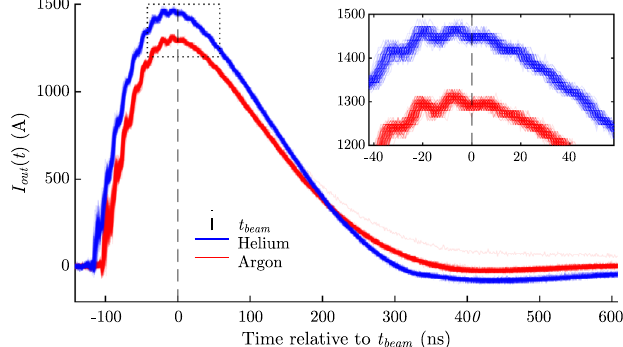
FIG. 2. Compact Marx bank current traces for the offset scans in helium and argon that are shown in Figs. 6 (180 traces) and 7 (136